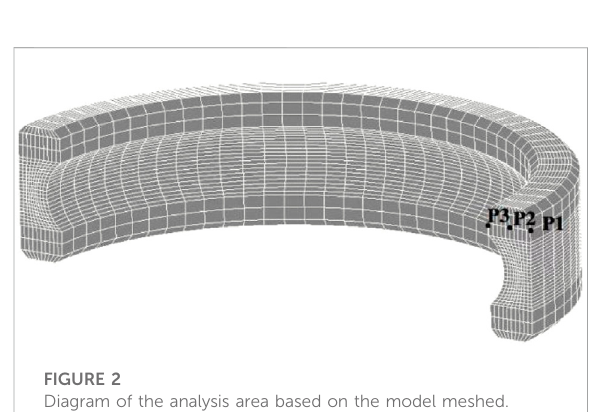
FIGURE 1 Flowchart of COSMAP simulation.